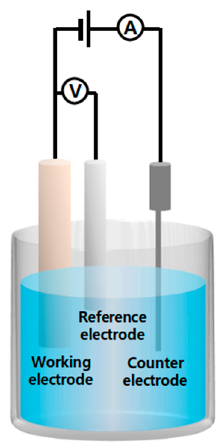
Figure 2. Three-electrode system schematic.